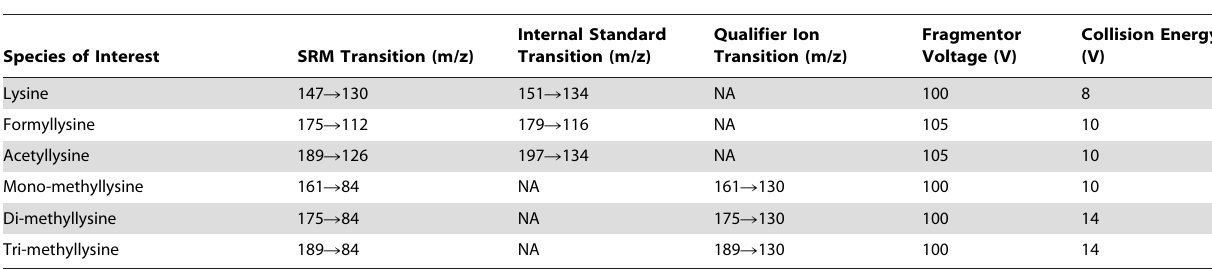
Table 3. Summary of mass spectrometry parameters for each